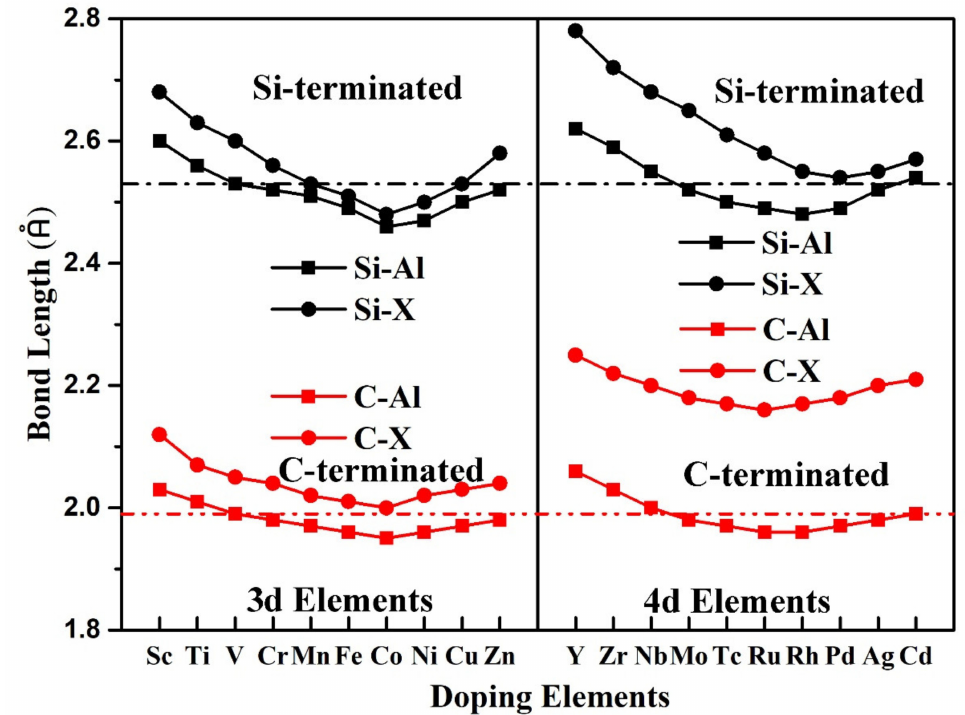
Figure 4. Bond lengths at the Al-X/SiC(0001) interface with different doping elements. The red and black dashed lines represent bond lengths of pristine C-terminated and Si-terminated Al(111)/6H- SiC(0001) interfaces,